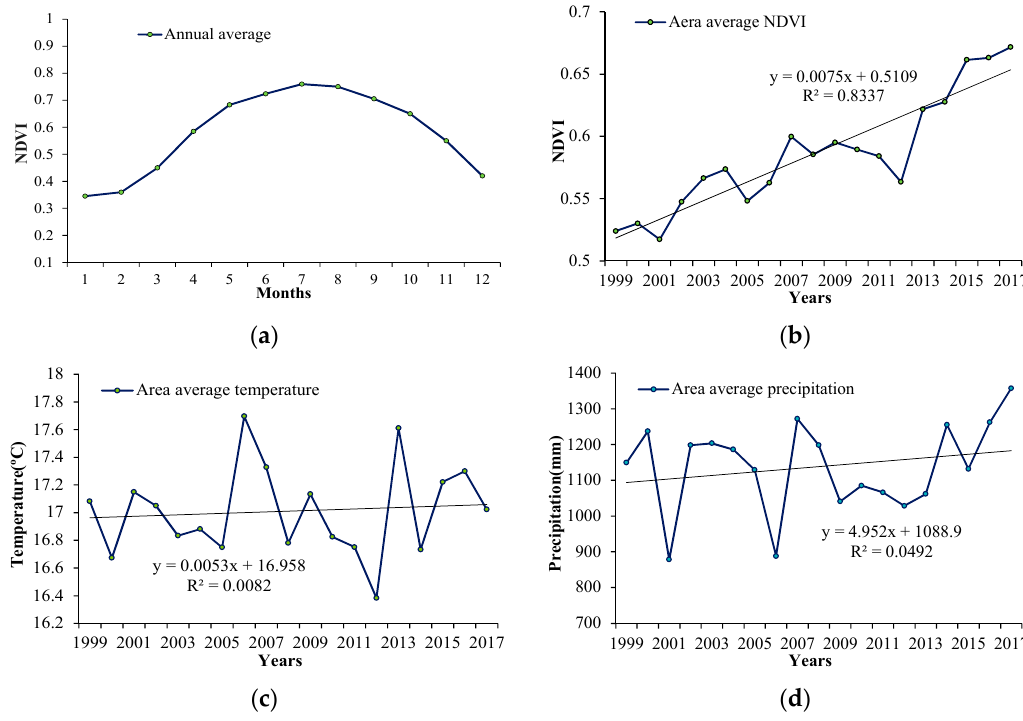
Figure 4. Variations of temperature, precipitation and normalized difference vegetation index (NDVI) in the study area: ( a ) monthly variation of NDVI from 1999 to 2017; ( b ) area average annual NDVI and linear trend; ( c ) area average annual temperature; ( d ) annual precipitation.